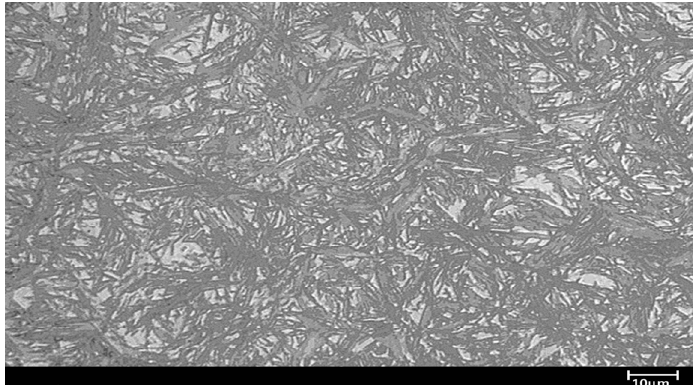
Figure 8: Microstructure of the Hypereutecoidic steel employed (locking